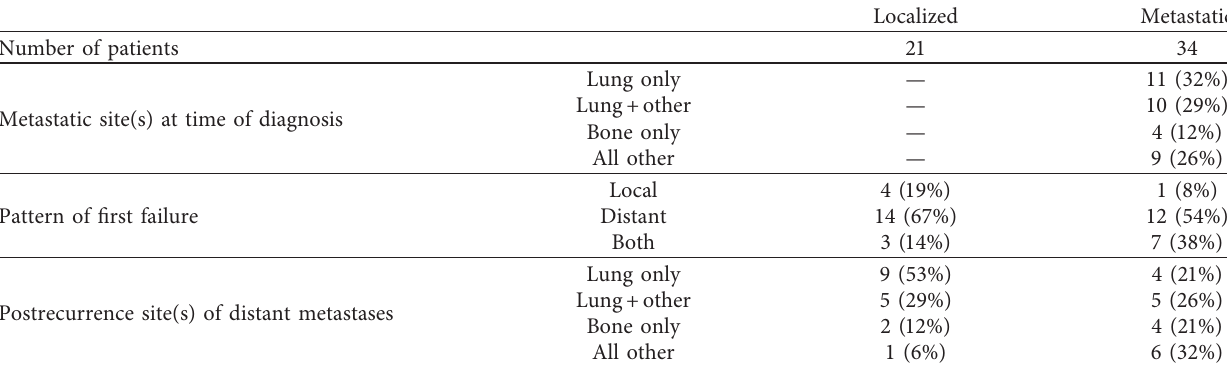
Postrecurrence site(s) of distant metastases